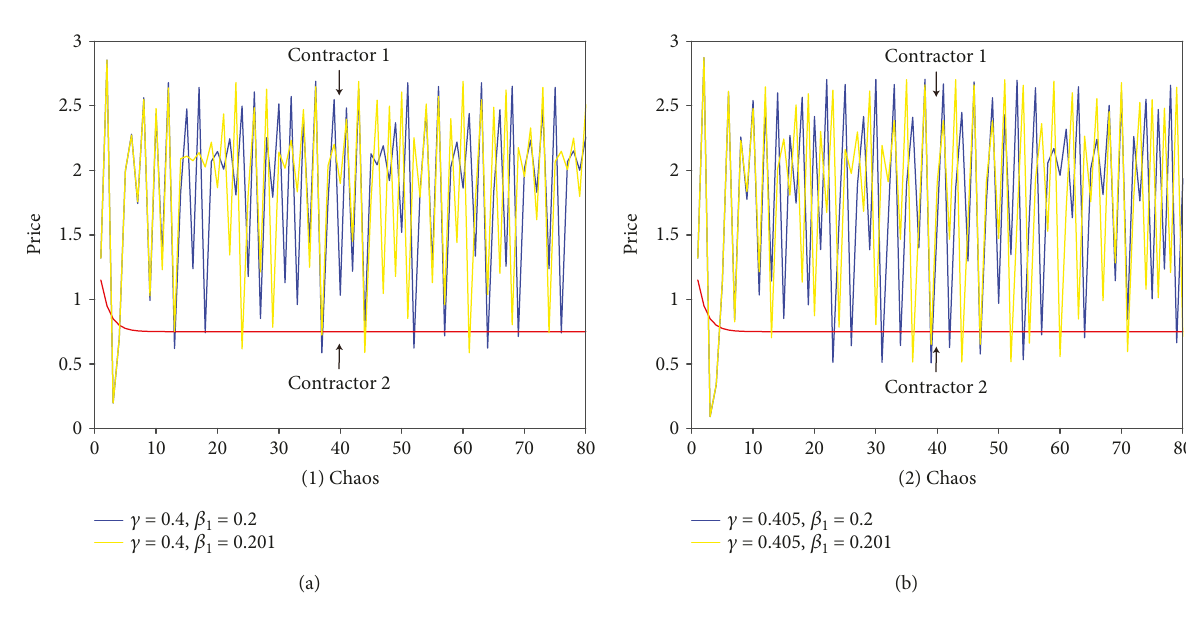
Figure 6: Sequence diagram in chaos in situation